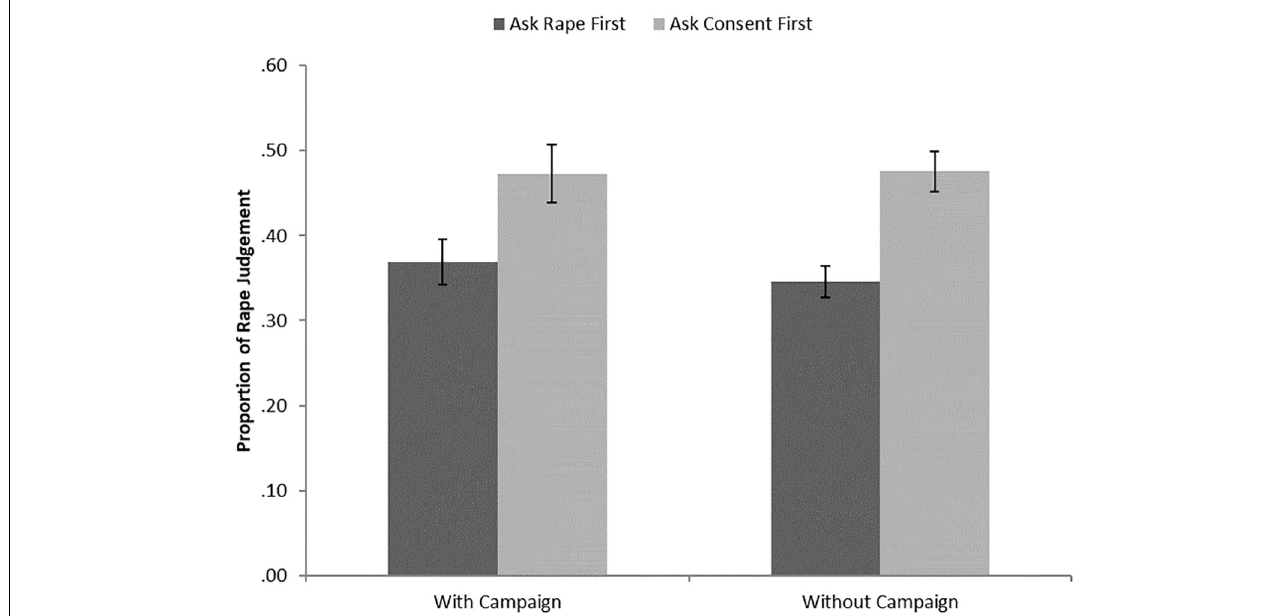
FIGURE 1 | Proportion of rape judgments.